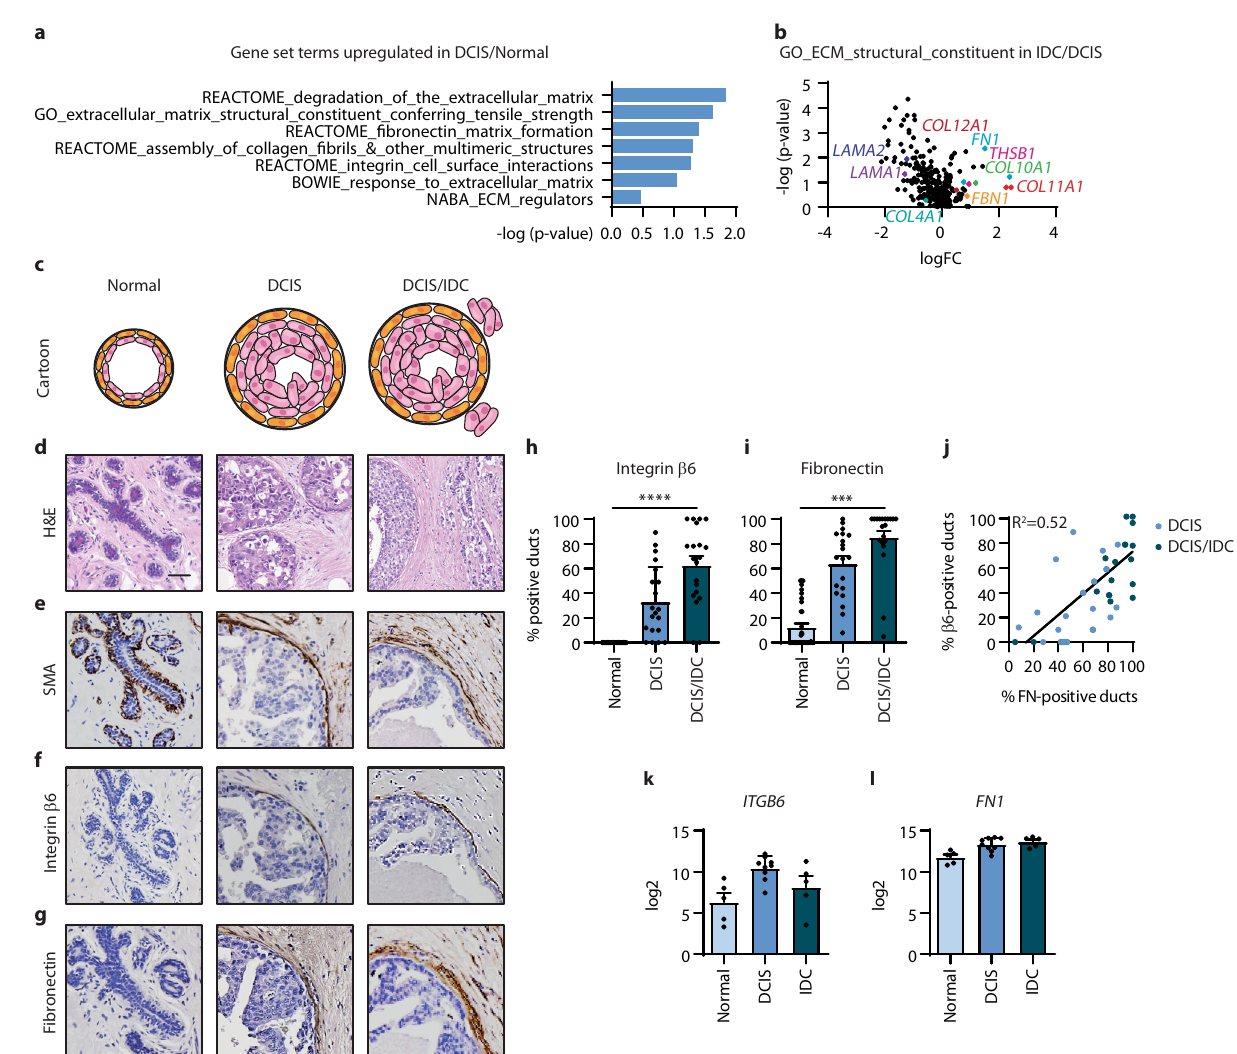
Fig. 1 Myoepithelial expression of integrin β 6 and periductal fi bronectin deposition correlates with human DCIS progression. a GSEA of transcriptional pro fi les from GEO series GSE21422 showing upregulated extracellular matrix (ECM) remodelling and integrin interaction gene set terms associated DCIS ( n = 9) compared to normal breast ( n = 5). b Scatter plot of p-value (-log10) vs. log fold change (logFC) for gene expression from the GO_extracellular_matrix_constituent gene set for microarray data for IDC ( n = 5) compared to DCIS ( n = 9). c Cartoon depicting a normal duct, a DCIS duct without (pure DCIS) and with co-existent invasion (DCIS/IDC). d Haematoxylin and eosin (H&E) staining of human breast tissue samples featuring adjacent normal ducts, DCIS and DCIS/IDC. Scale bar, 100 μ m. e – g Representative images of smooth- muscle actin (SMA) ( e ), integrin β 6 ( f ) and fi bronectin ( g ) by immunohistochemical staining in human breast tissue samples featuring adjacent normal ducts, DCIS and DCIS/IDC. h , i Bar graphs showing the mean and individual percentage of ducts positive for integrin β 6 ( h ) or fi bronectin ( i ) in adjacent normal ( n = 40), DCIS ( n = 20) and DCIS/IDC ( n = 20) patient samples (error bars, + s.e.m). **** P < 0.0001 (h, ordinary one-way ANOVA and i, Kruskal – Wallis one-way ANOVA). See Supplementary Table 1 for patient information. j , Scatter plot depicting the linear regression of the percentage of positive DCIS ducts for integrin α v β 6 ( β 6) and fi bronectin (FN) in serial human tissue sections as in (f,g) ( n = 40). k , l , mRNA expression of ITGB6 and FN1 in normal breast tissues ( n = 5), DCIS ( n = 9) and IDC ( n = 5) (error bars, + s.e.m). * P = 0.019 ( k ) and ** P = 0.0023 ( l ) (ordinary one-way